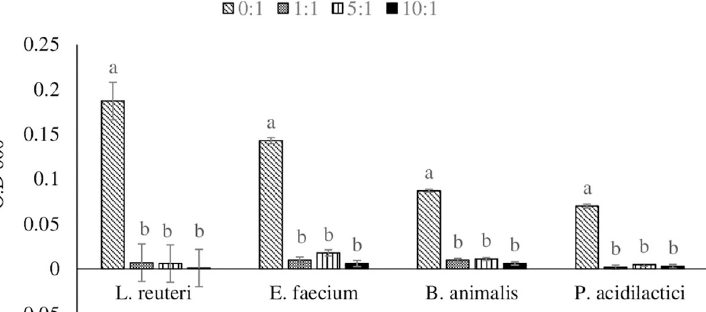
Fig 1. Effect of cell- free probiotic supernatants on S . Enteritidis in vitro proliferation. Overnight culture of single isolated colonies of Lactobacillus reuteri , Enterococcus faecium , Bifidobacterium animalis , and Pediococcus acidilactici probiotic strains were centrifuged at 4,500 X g for 10 min to collect supernatants. The supernatant was filtered using a 0.22 μ m filter to collect cell-free supernatant. 10 μ l of S . Enteritidis overnight culture was incubated with 0:1, 10:1, 5:1, or 1:1 cell-free supernatant: pathogen dilutions. The absorbance was measured at 600nm at 24 hours. n = 3. Values ± SEM of pooled samples of 3 wells/treatment. Bars ( ± SEM) with no common superscript ( a, b ) differ significantly (P <